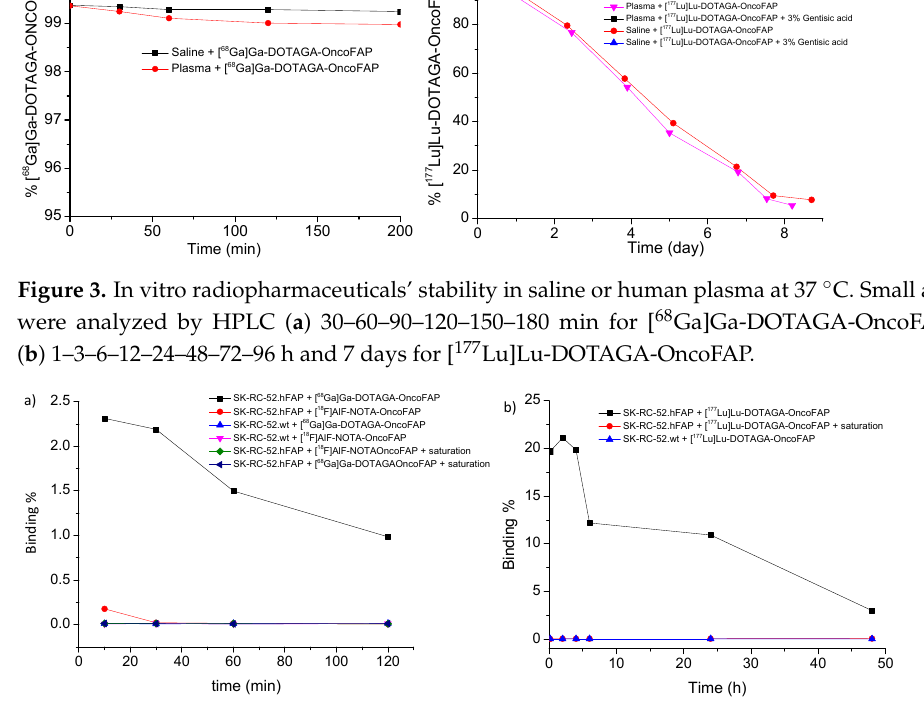
Figure 2. Co-elution experiments performed with [ 68 Ga]Ga-DOTAGA-OncoFAP conjugate. [ 68 Ga]Ga-DOTAGA-OncoFAP forms a stable complex with recombinant hFAP. [ 68 Ga]Ga-DOTAGA- OncoFAP (500 kBq) and hFAP (2 μ M, 100 μ L) eluted on a PD-10 column. All [ 68 Ga]Ga-OncoFAP and [ 18 F]AlF-OncoFAP radio-conjugates were highly stable (>99% of intact compound) in 0.9% saline solution and in human plasma at 37 °C for 2 h. On the other hand, a stability test of [ 177 Lu]Lu-DOTAGA-OncoFAP radiolabeled batch showed the presence of radiolysis of about 10% every 24 h, which was significantly re- duced to about 2% within 8 days by the addition of 20 mg of gentisic acid as a radical scavenger (Figure 3b) [15,16]. All the radiolabeled preparations of OncoFAP derivatives exhibited high hydrophilicity. Details are given in Supplementary Material.